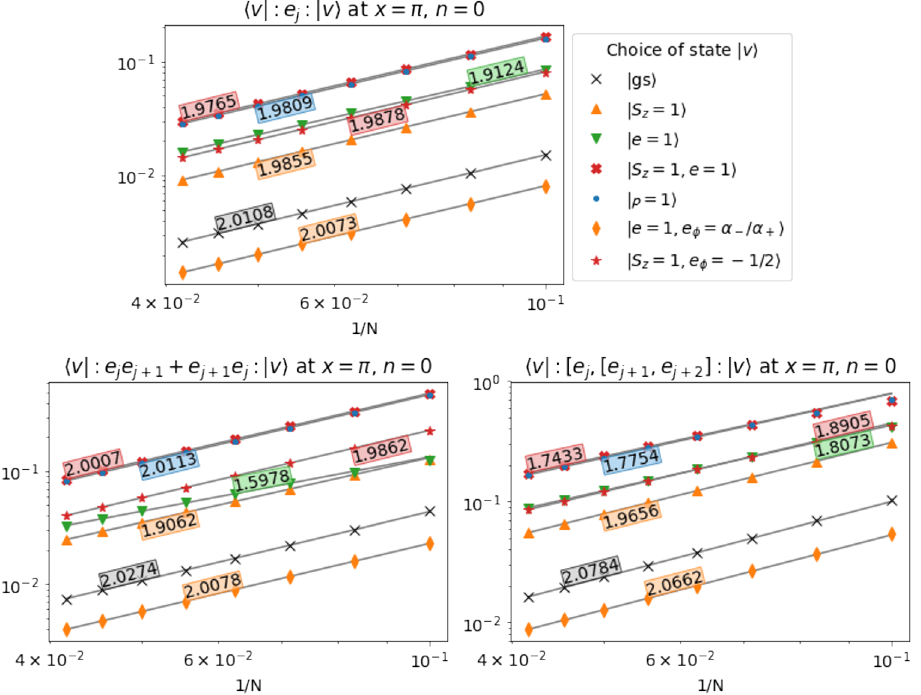
Figure 5 . Absolute value of matrix elements, plotted using the same conventions as in (cid:12)gure 3 but with the choice of j u i = j v i . The operators are here normal ordered: : O : (cid:17) O (cid:0) O 1 with O 1 being the ground state expectation value as N ! 1 . This value is given for e j in (2.9), and for e j e j +1 + e j +1 e j and [ e j ; [ e j +1 ; e j +2 ]] in